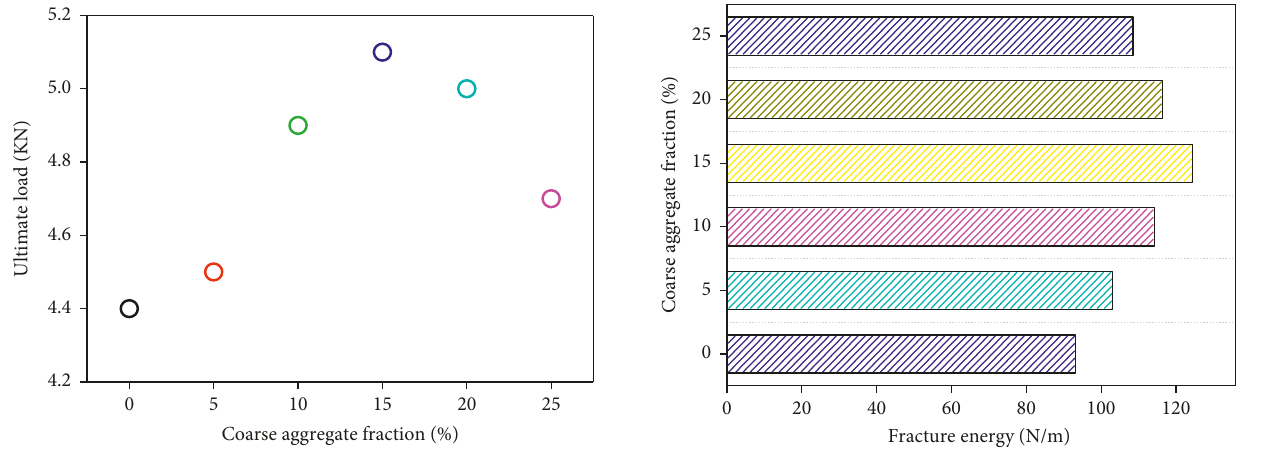
Figure 7: Fracture energy of the coarse aggregate interlocking